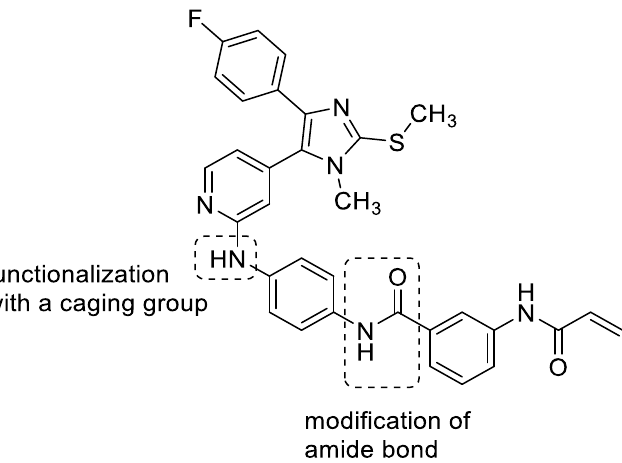
Figure 4. Aim of the present study. Inversion and methylation of the amide bond present between the two benzene rings. Installation of a photocleavable protecting group at the secondary amine at the pyridin-C2-amino function.